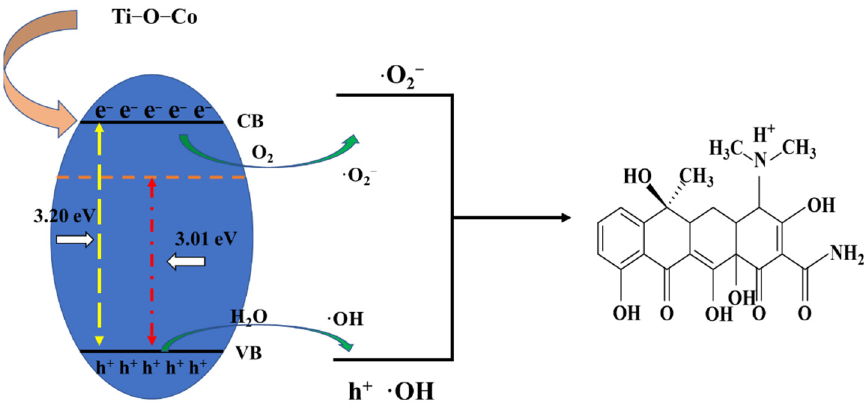
Figure 11. Reaction mechanism of visible-light-driven photocatalytic degradation of TCH on Co- TiO 2